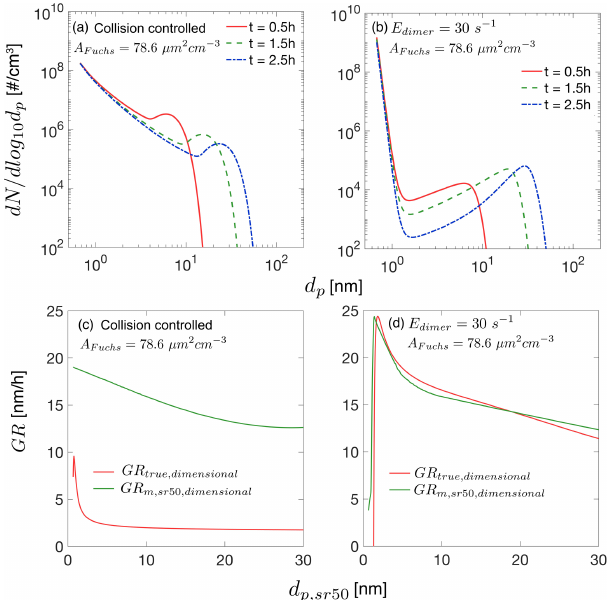
Figure B1. Dimensional particle size distribution and growth rates. mensionless solution using Eq. (6). The dimensional quantities involved in the conversions are R = 1 × 10 6 cm − 3 s − 1 , β 11fm = 4 . 27 × 10 − 10 cm − 3 s − 1 and v 1 = 1 . 62 × 10 − 22 cm 3 . The Fuchs sur- √ L = 0 . 2. (a) Parti- face area is 78.6µm 2 cm − 3 , corresponding to cle size distribution for collision-controlled nucleation at t = 0 . 5, 1.5 and 2.5h. (b) Particle size distribution for nucleation with evap- oration at t = 0 . 5, 1.5 and 2.5h. Monomer evaporation rate from the dimer is 30s − 1 , corresponding to a dimensionless evaporation constant E = 1 × 10 − 3 . (c) The dimensional particle growth rates for collision-controlled nucleation as is shown in panel (a) . (d) The dimensional particle growth rates for nucleation with evaporation as is shown in panel (b)